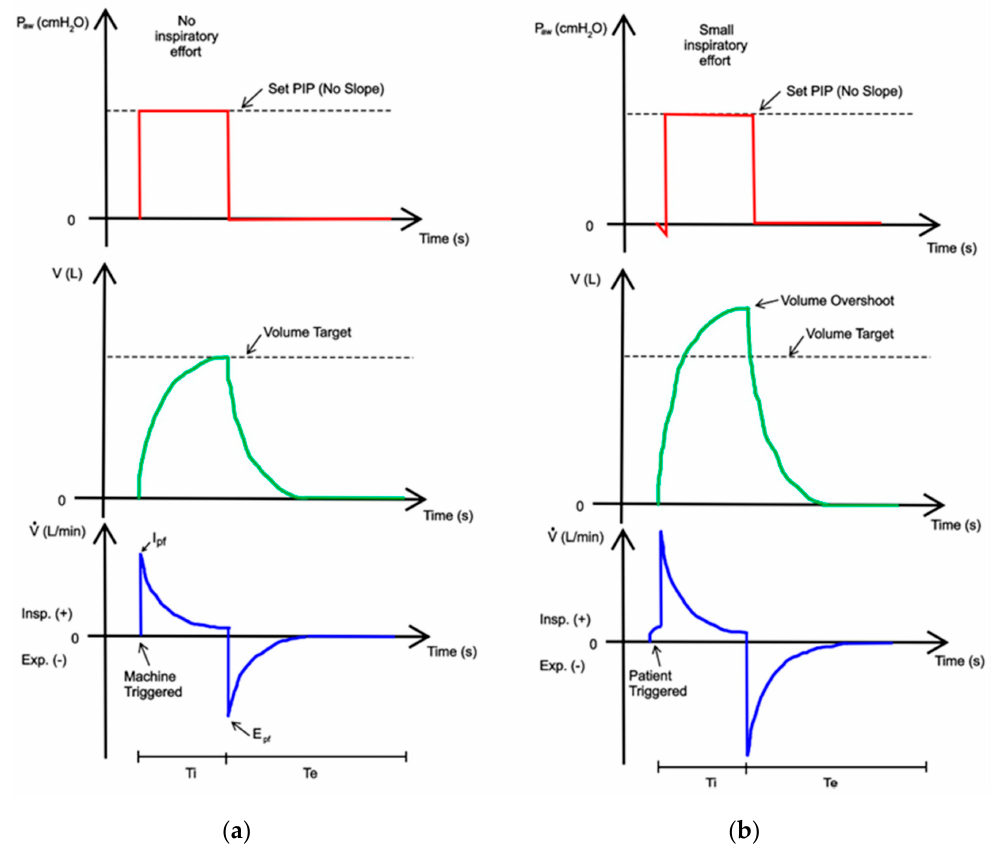
Figure 8. A display of pressure, volume, and flow waveforms during PC ‐ CMV mode: ( a ) machine − triggered; ( b ) patient − triggered. The theoretical waveforms have been adapted from [44].